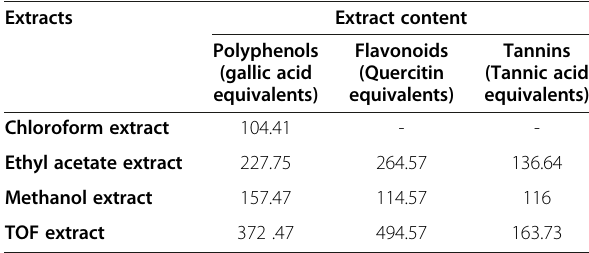
Table 1 Quantitative phytochemical screening of extracts from D. gnidium